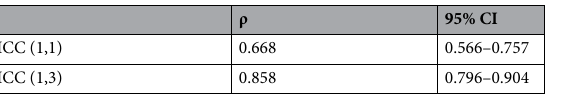
Table 2. Intra-rater reliability. ICC intraclass correlation coefficients, CI confidence